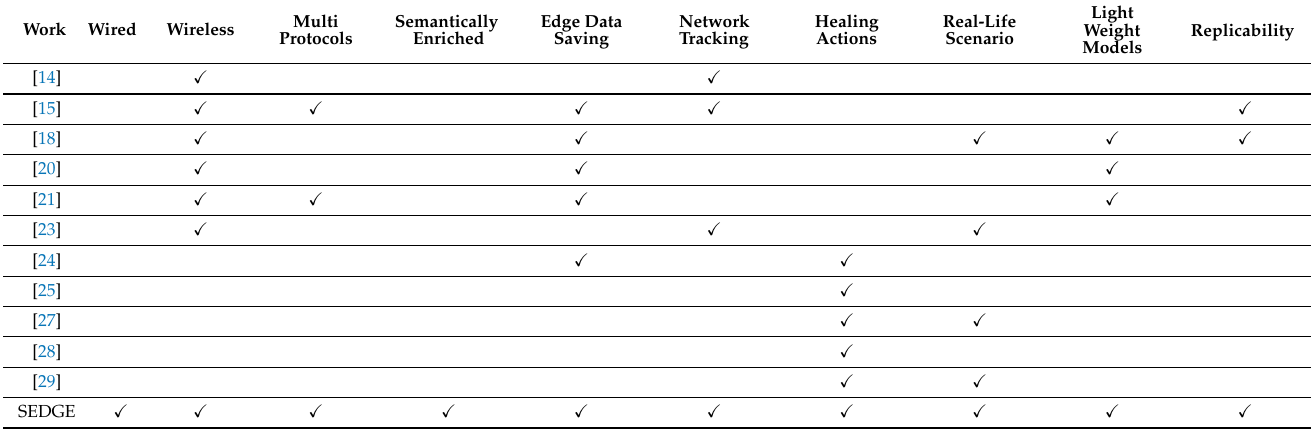
Table 1. Summary of related work and comparison with the SEDGE approach.